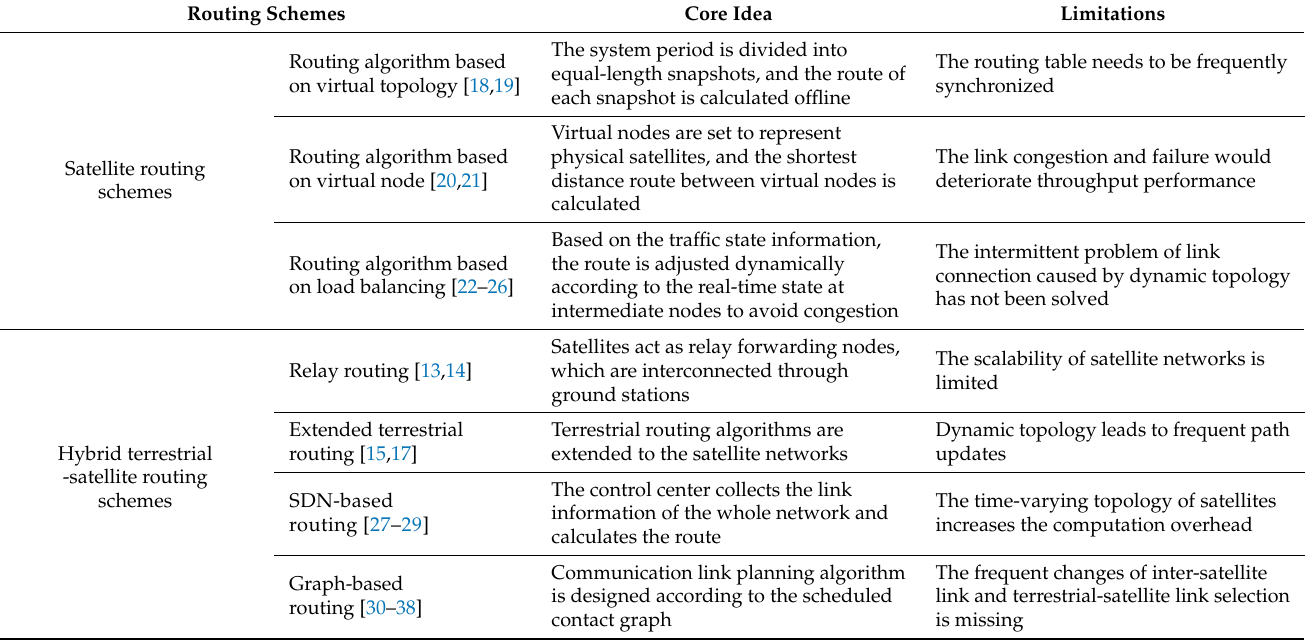
Table 1. Summary of routing protocols in